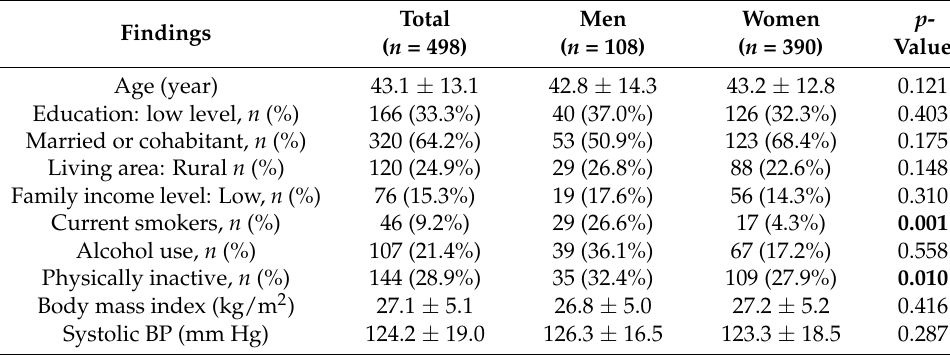
Table 1. General characteristics of study population.